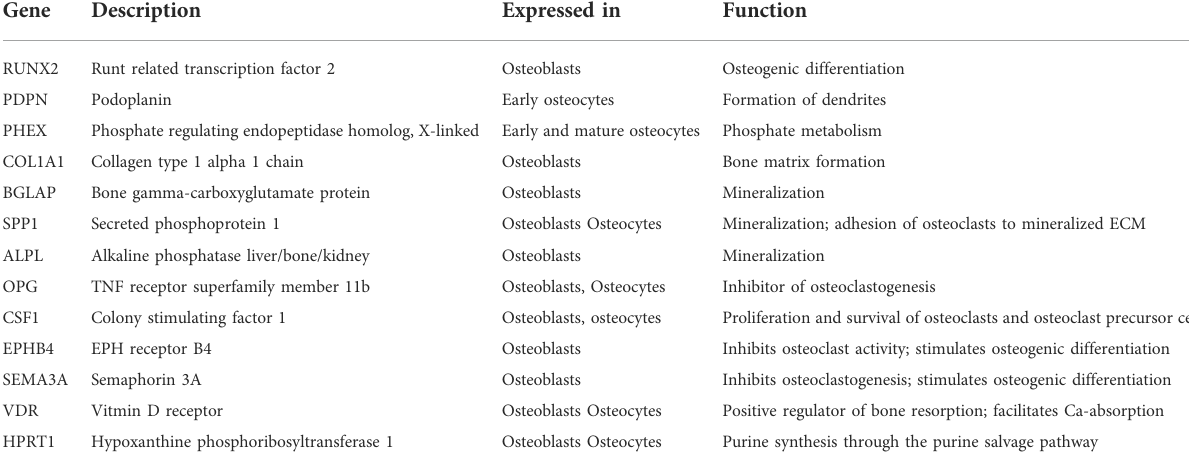
TABLE 1 Target genes and reference gene for the comparative gene transcription analysis in osteoblasts derived from alveolar and iliac crest bone (Bonewald, 2011; Stephens et al., 2011; Bellido, 2014). Primer Assay information are listed in Supplementary Table S2.